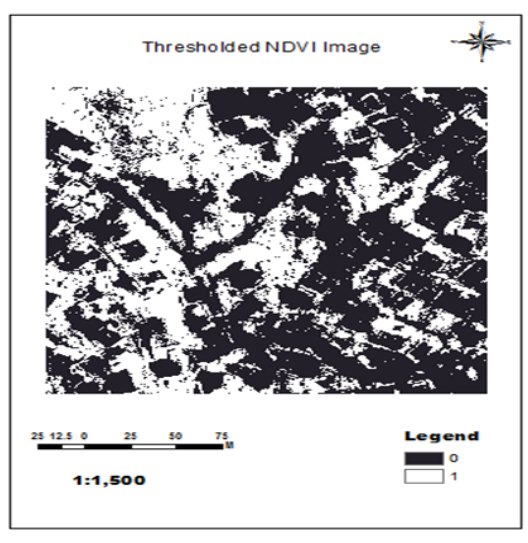
Figure 9. NDVI image after applying a threshold.